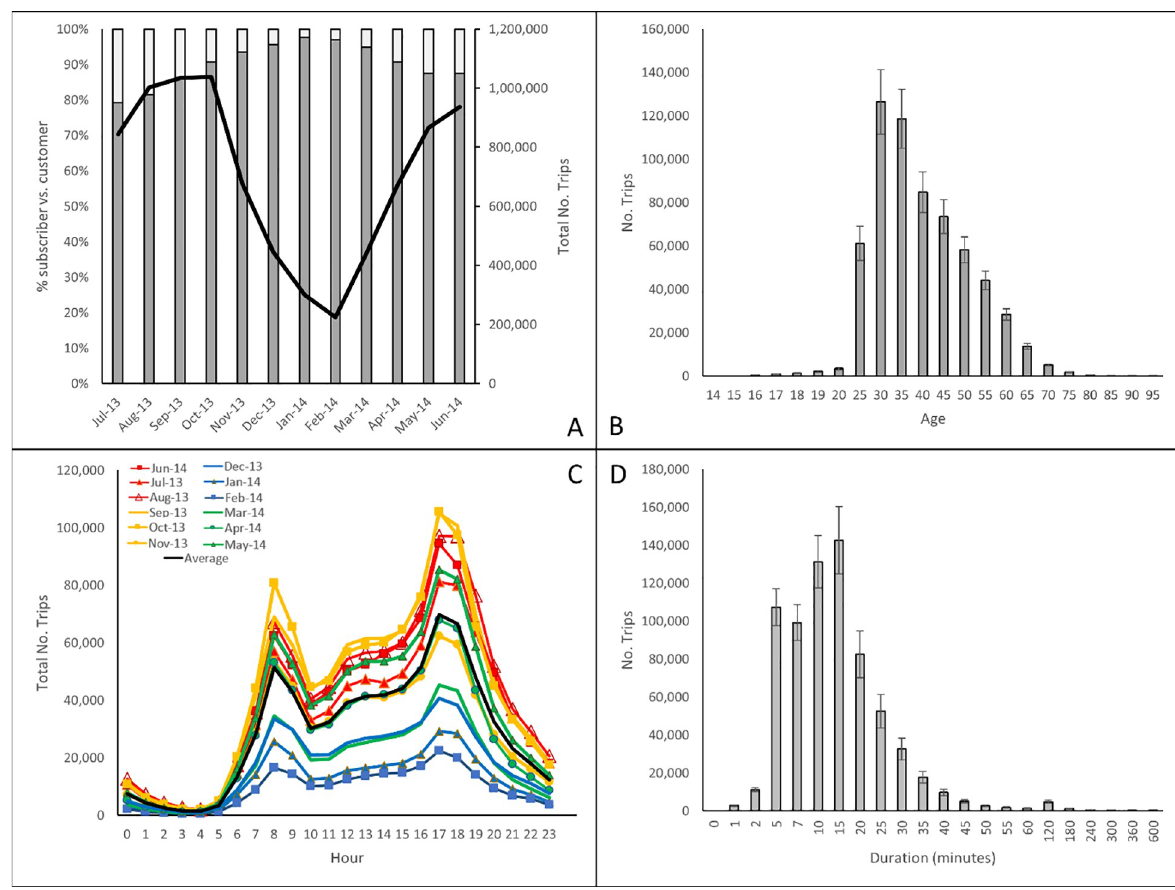
Fig 2. Breakdown of bike trips between July 2013 and June 2014 by (A) customer (subscriber (grey bars) vs customer (white bars); total number of trips (solid black line)), (B) age (+/-SE), (C) time of day (blue = winter months, red = summer months, green = spring months, brown/ yellow = autumn months, black line = average) and (D) duration (minutes) (+/-SE).